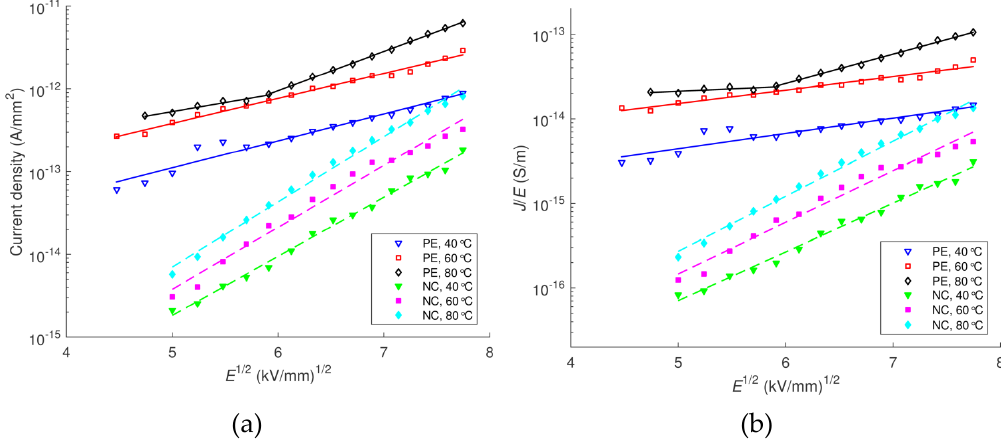
Figure 6. (a) Schottky plots (field-dependent currents) and (b) Poole – Frenkel plots (field-dependent Figure 6. ( a ) Schottky plots (field-dependent currents) and ( b ) Poole–Frenkel plots (field-dependent conductivities) for reference LDPE and LDPE/Al 2 O 3 3 wt% nanocomposite at various temperatures. conductivities) for reference LDPE and LDPE / Al 2 O 3 3 wt% nanocomposite at various temperatures. Markers are measured results and lines are introduced for fitting. Markers are measured results and lines are introduced for Table 3. Fitting parameters in different conduction models. Note that the obtained values of the relative permittivity ε r below 1 do not have physical significance.